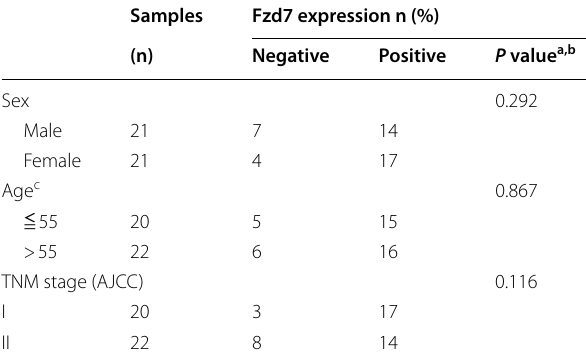
Table 1 The relationship between Fzd7 and basic clinical information of PDAC